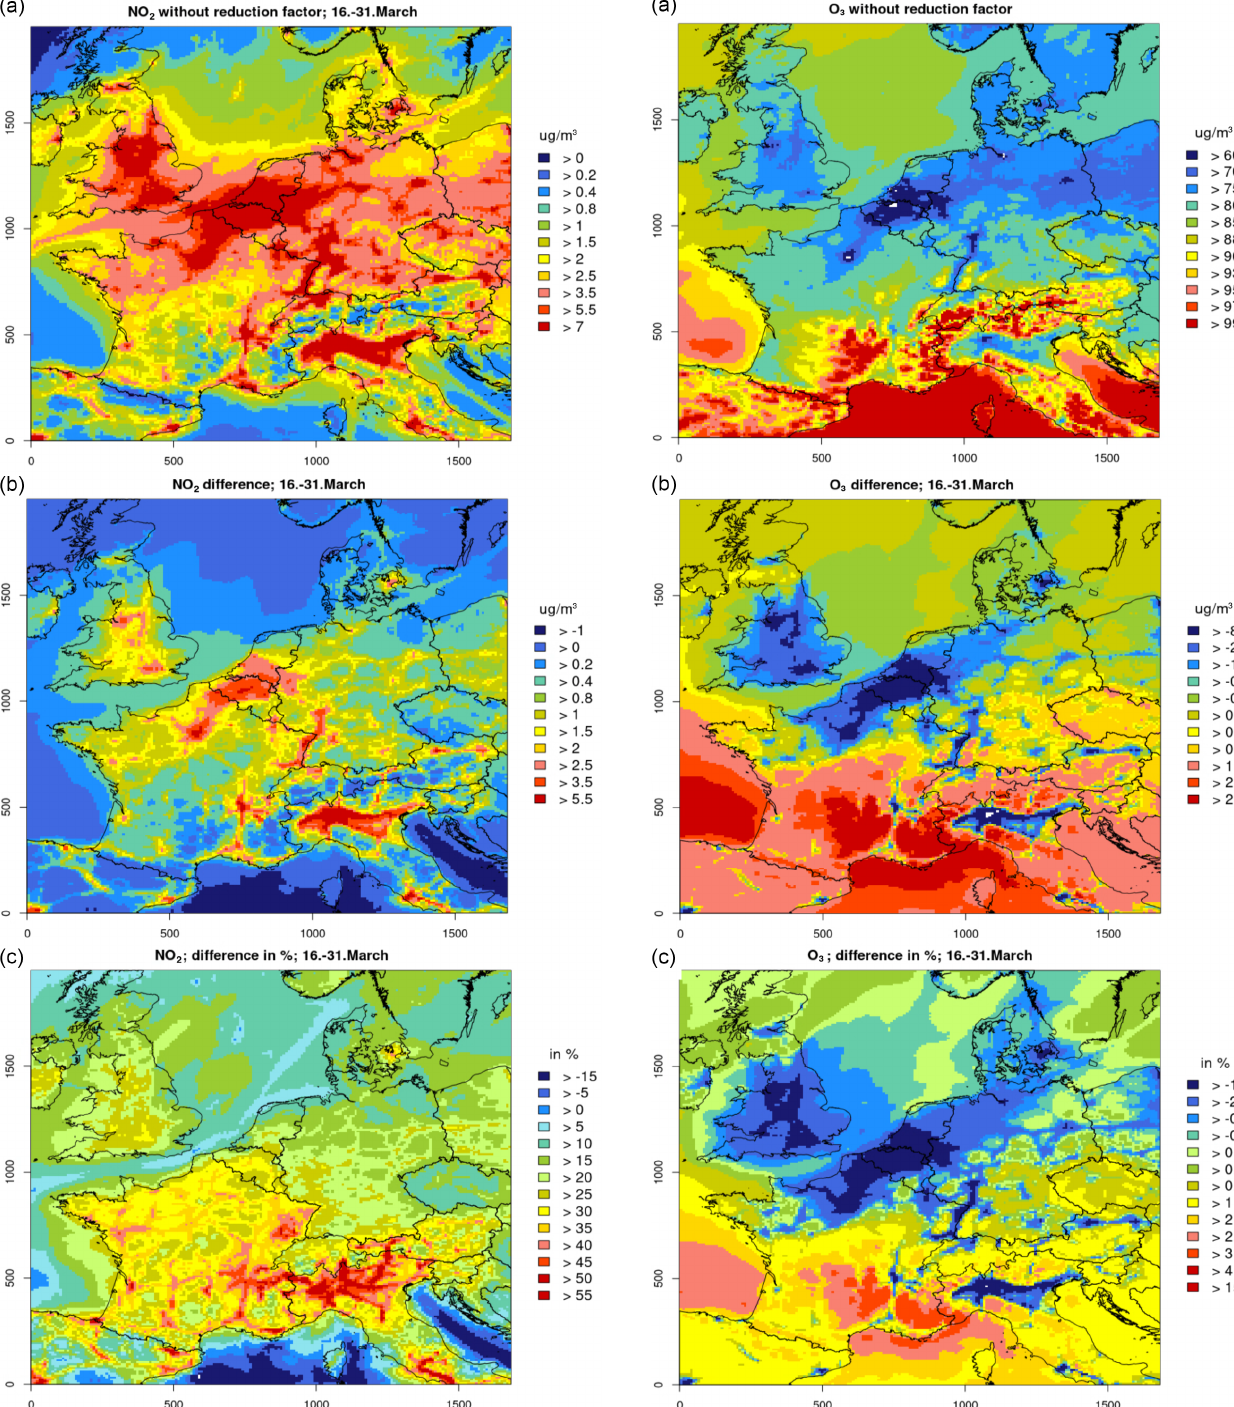
Figure 10. CMAQ results for NO 2 concentrations in central Eu- rope between 16 and 31 March 2020. (a) Concentrations without lockdown measures (noCOV run). (b) Absolute concentration re- ductions due to lockdown measures (noCOV – COV run). (c) Rel- ative concentration reductions due to lockdown measures (noCOV – COV run). Positive values for absolute and relative differences denote high reductions.